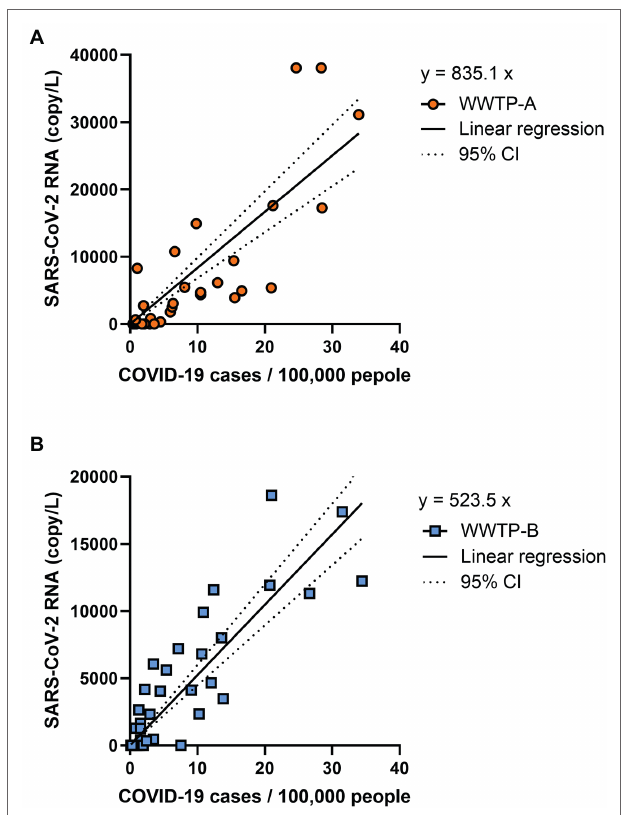
FIGURE 4 | Correlation of COVID-19 cases and SARS-CoV-2 copy number. The daily reported COVID-19 cases per 100,000 people and SARS-CoV-2 RNA copy number in WWTP-A (A) and WWTP-B (B) were analyzed using linear regression. Lines indicate the linear regression and dotted lines indicate 95%